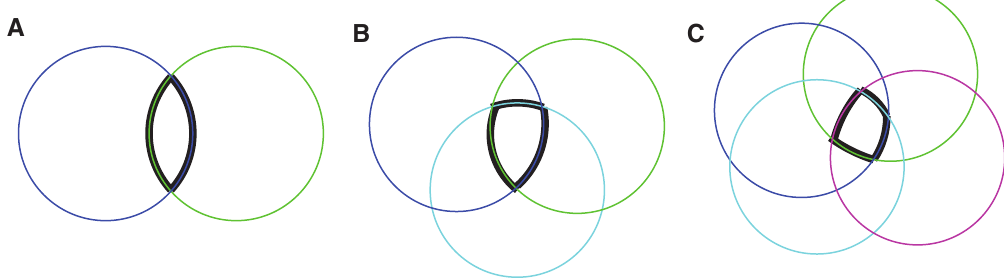
Figure 8: Schematic demonstration of the solution line in a 2-D design problem for (A) two; (B) three; (C) four tolerance surfaces.